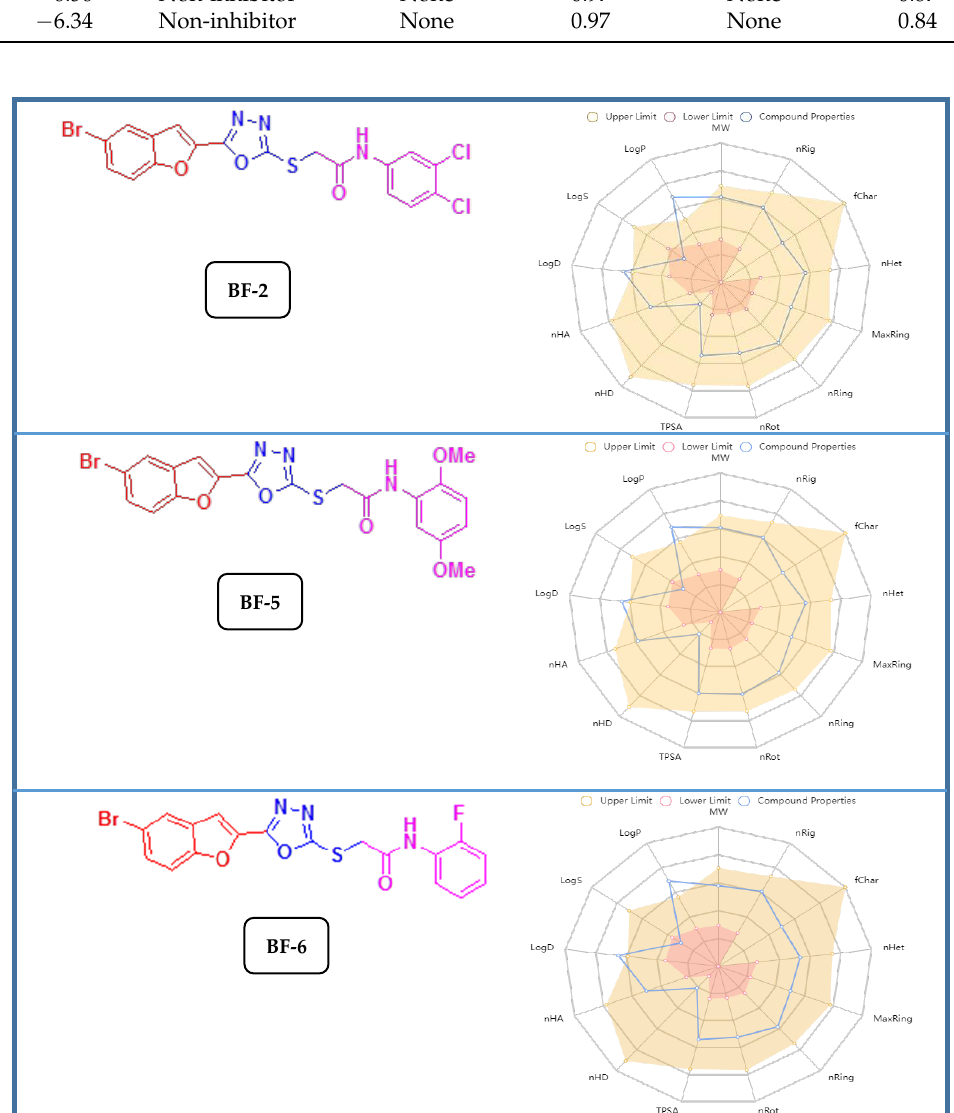
Figure 10. Structures and graphical representation of pharmacokinetic profiles of BF-2, BF-5 and BF-6 Table 6. ADME&T profile of bromobenzofuran-oxadiazoles BF-2 , BF-5 and BF-6.